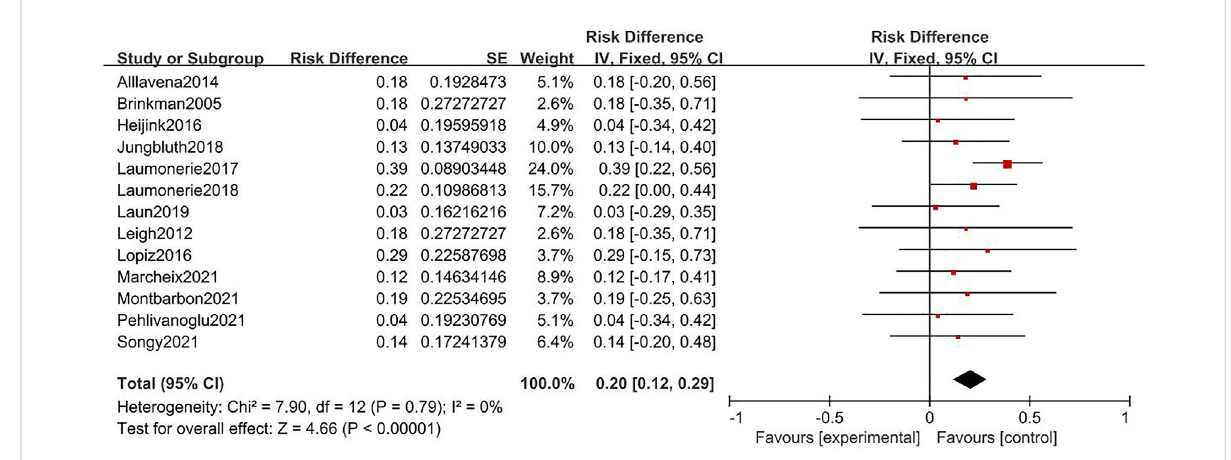
FIGURE. 2 Forest plot for rate of reoperation of cemented fi xation.